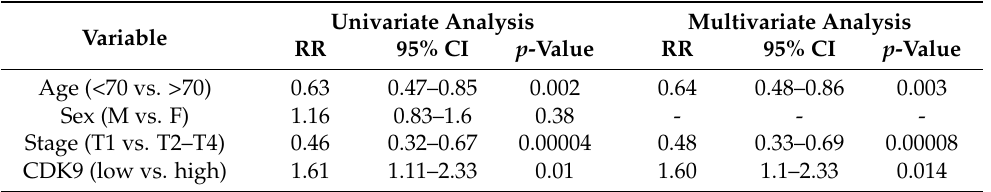
Figure 4. Overall survival analysis of TCGA cohort ( a ) overall survival in low CDK9 and high CDK9 groups (5-year OS 57.75% vs. 35.44%), respectively ( p = 0.009); ( b ) overall survival by CDK9 expression quartiles. Table 5. Univariate and multivariate analysis of overall survival in the TCGA cohort.